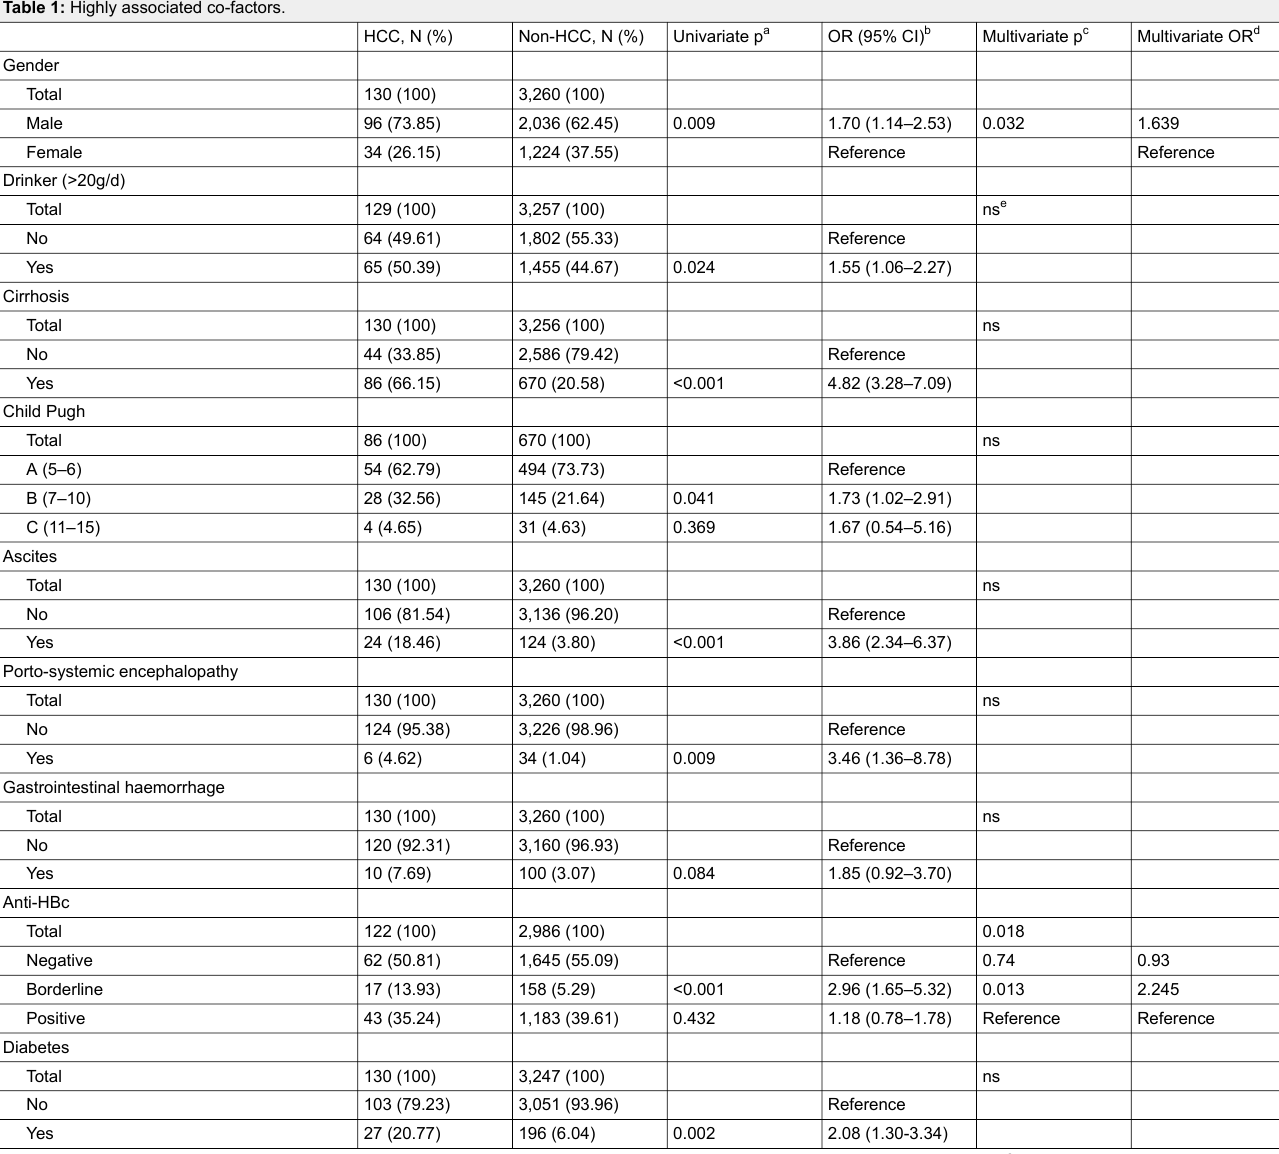
Table 1: Highly associated